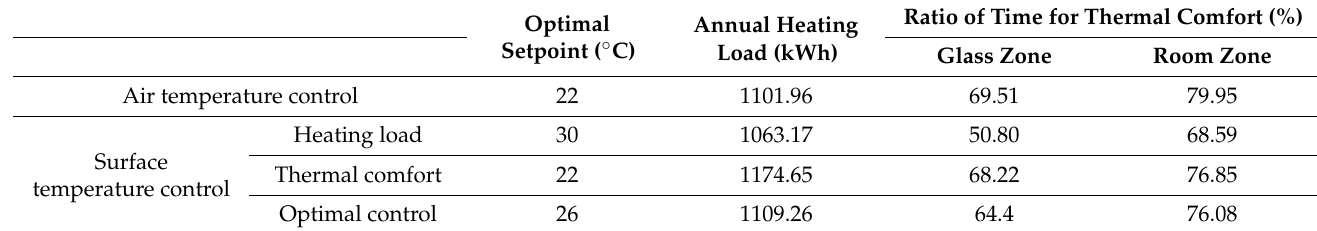
Figure 20. Annual heating load and ratio of time for thermal comfort. Table 9. Setpoint, heating load, and thermal comfort for each control method.